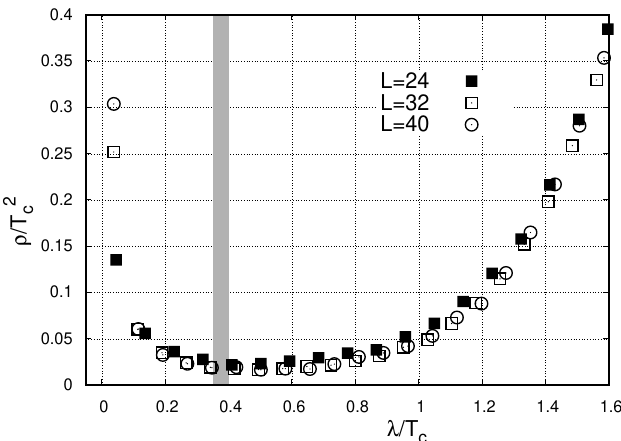
Figure 1. The spectral density, Equation (9) (here normalized by the volume), of the overlap Dirac operator in quenched QCD (i.e., SU(3) pure gauge theory), just above the phase transi- tion at T = 1.045 T c . The grey band indicates the point separating the lowest, topological modes from the rest (its width equals the corresponding uncertainty). From Ref. [58]. (Figure